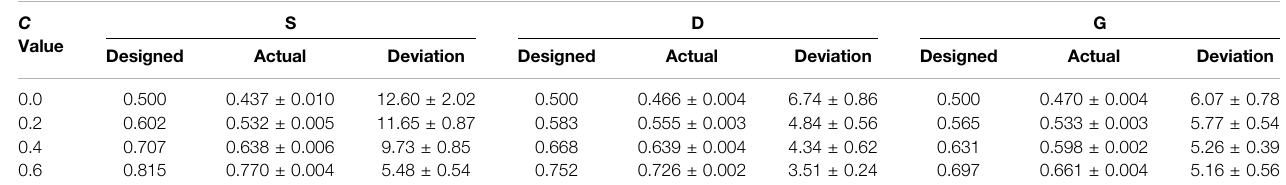
TABLE 2 | Designed porosity, actual porosity ( n = 6) and deviation ( n = 6, %).